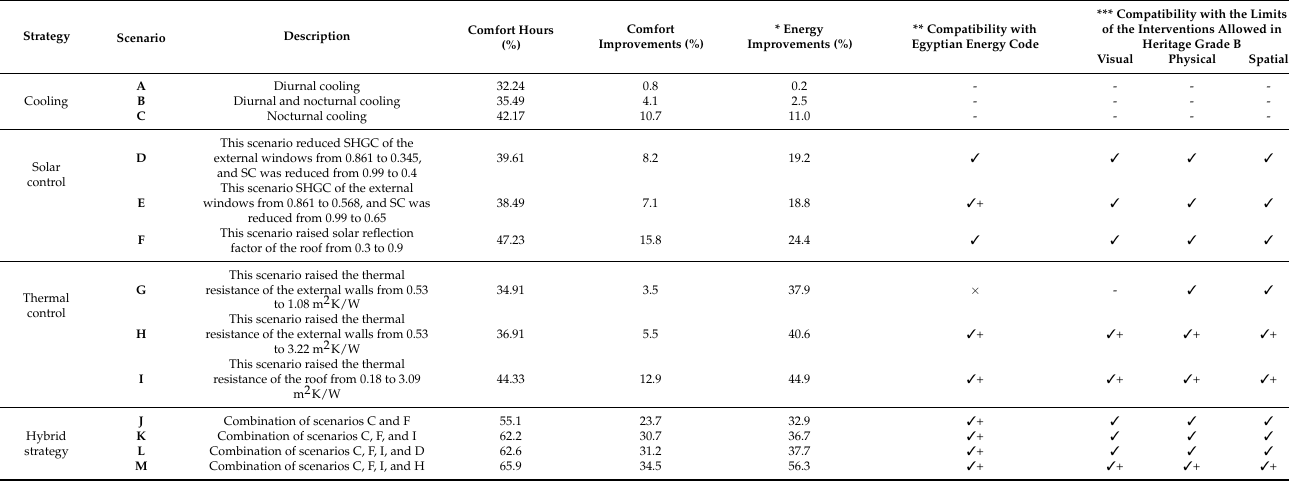
Figure 8. A comparison between the comfort hours in the base case and the proposed hybrid scenarios. Table 7. Evaluation of the proposed scenarios to define the “optimum